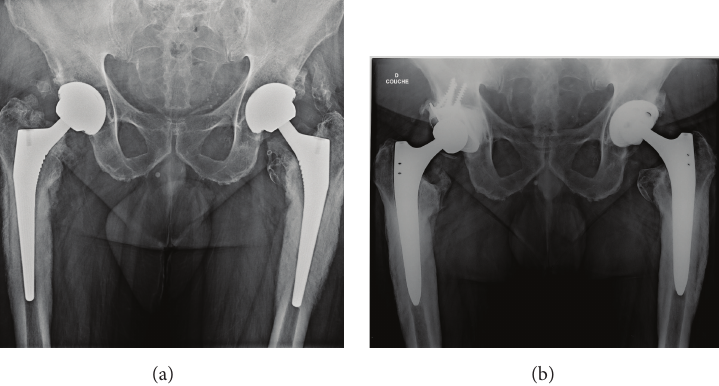
Figure 1: (a) Preoperative AP view case 1 showing typical features of intense femoral periosteal reaction suggesting pain was related to infection. (b) Case 1 AP view at 3 years of follow-up showing regression of periosteal